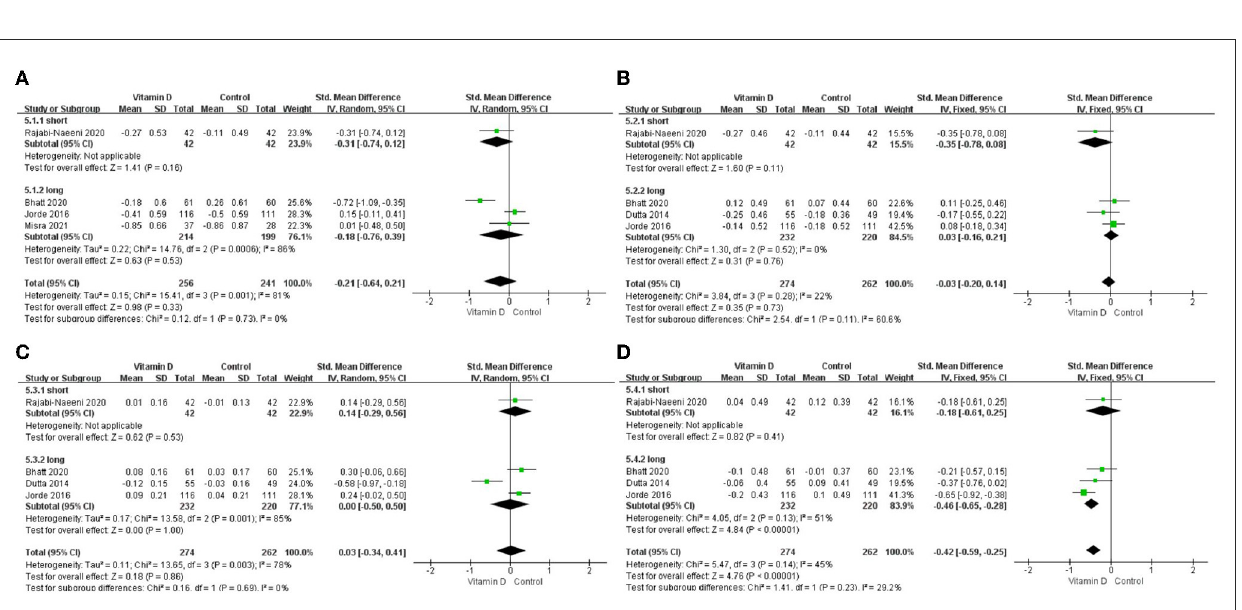
intervention group had been observed only in the long-duration subgroup but not in the short-duration subgroup. Additionally, the vitamin D levels in the short-duration subgroup of the study (30) did not change to achieve vitamin D sufficiency after only 8 weeks of treatment. This implied that the relatively medium-dose group in our analysis was probably affected by the short duration